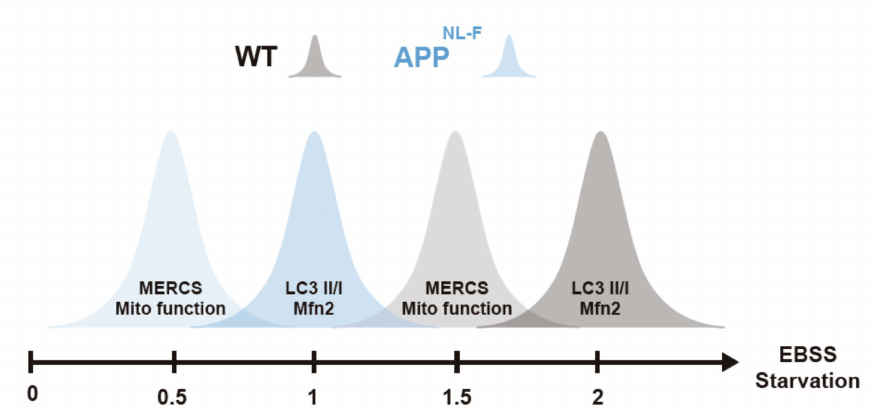
Figure 5. Increase in connectivity between endoplasmic reticulum (ER) and mitochondria as well as mitochondria function occurs before autophagosome formation. Graphical representation of alterations of MERCS and mitochondria ultrastructure / function, autophagosome formation and Mfn-2 levels during starvation. Starvation axis represents starvation times in